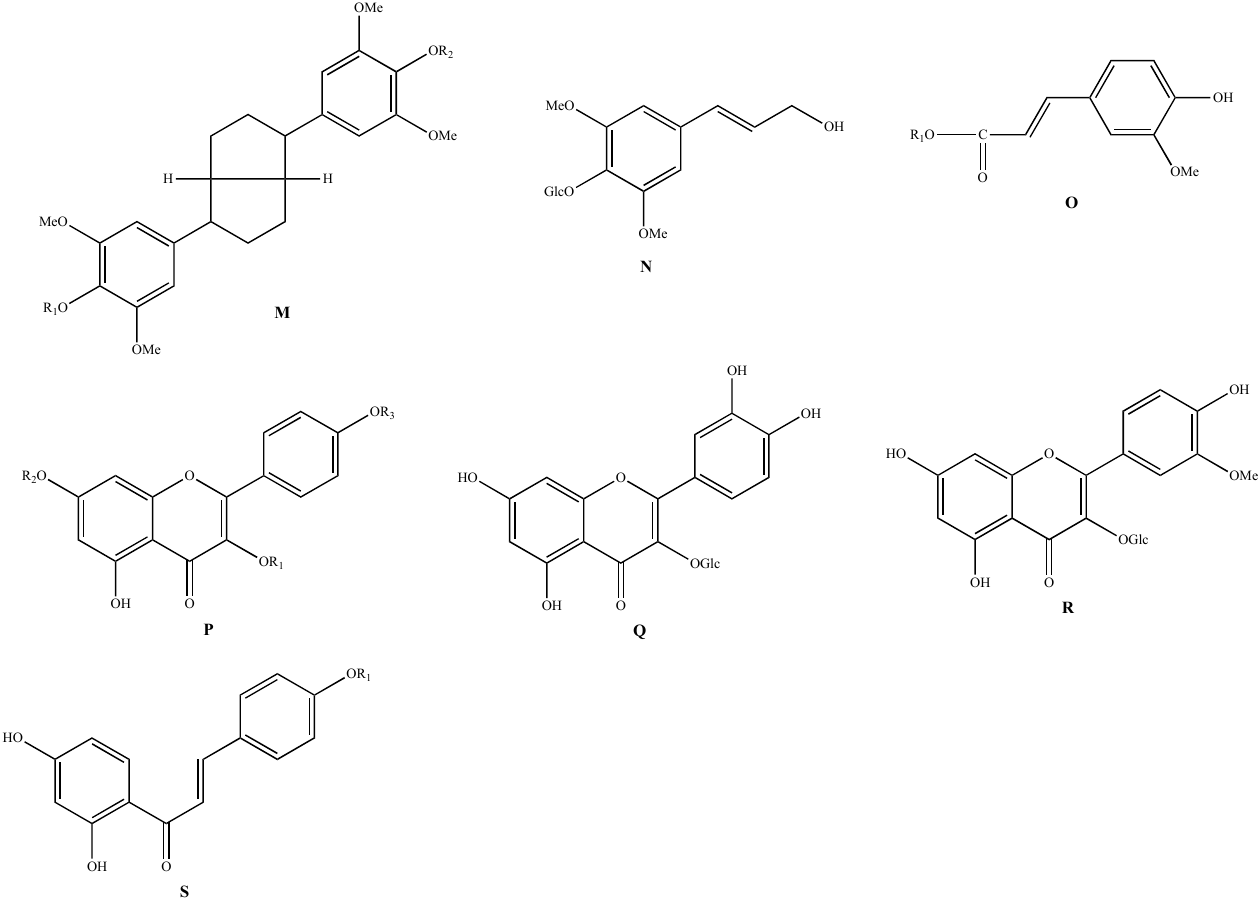
Figure 5. Structure of phenylpropanoids and fl avonoids isolated from AMB.